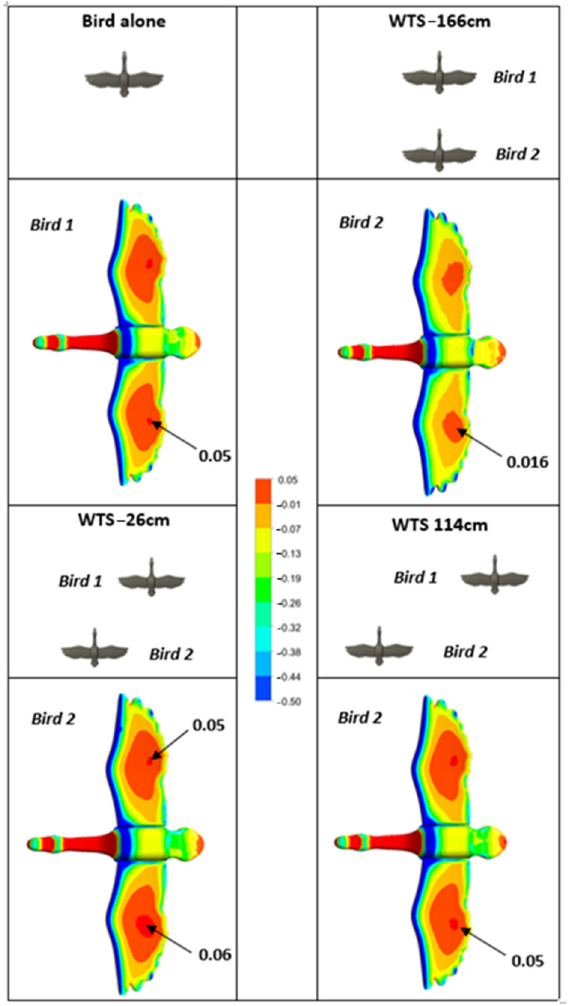
Figure 7. Distribution of pressure coefficients on the underside of the single bird and the second bird of the following cases: aligned birds, WTS = − 26 cm, − 166 cm and 114 cm. For each case, depth = 1.73 m.